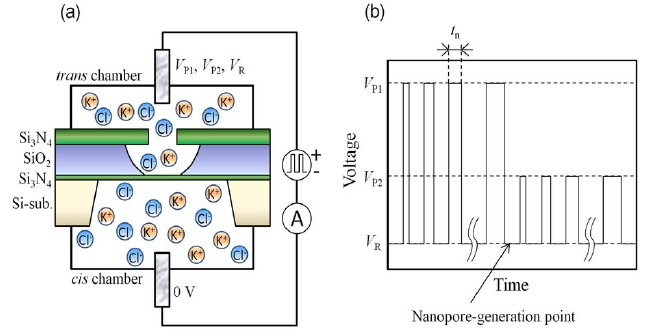
Figure 15. ( a ) Setup for multilevel pulse-voltage injection (MPVI). Cis and trans